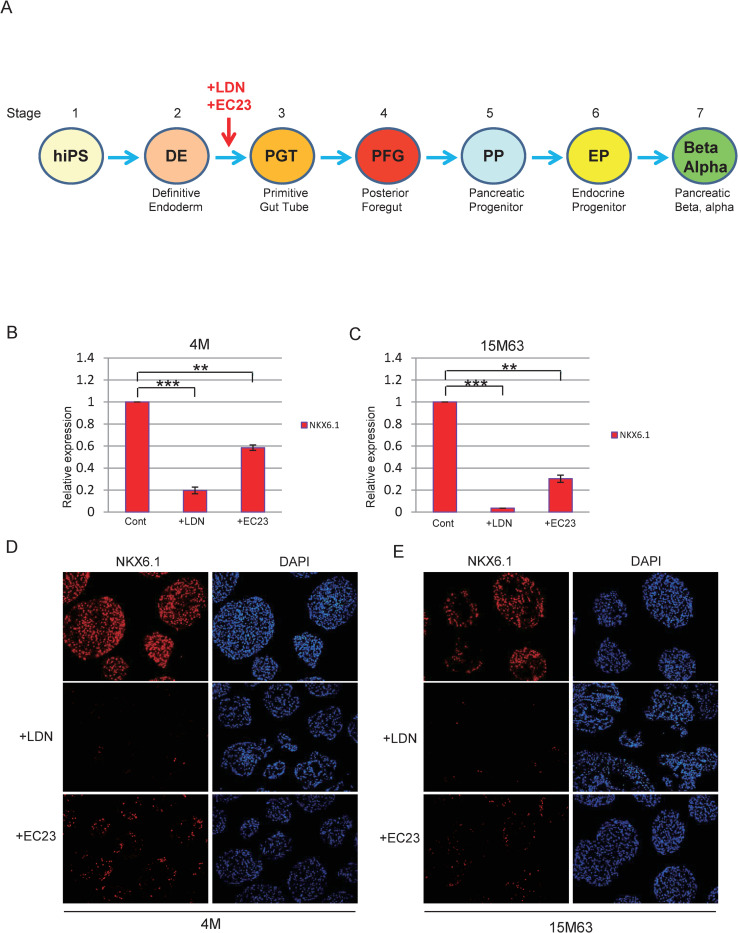
Scheme of the differentiation process and effects of LDN193189 and EC23.(A) Scheme of the stepby-step differentiation protocol. (B, C) Analysis of NKX6.1 mRNA expression in cells treated with LDN193189 or EC23 by qPCR B; 4M, C; 15M63. N = 2 each. **P<0.01, ***P<0.001.(D, E) Analysis of NKX6.1 protein expression in cells treated with LDN193189 or EC23 by immunocytochemistry. D; 4M, E; 15M63.